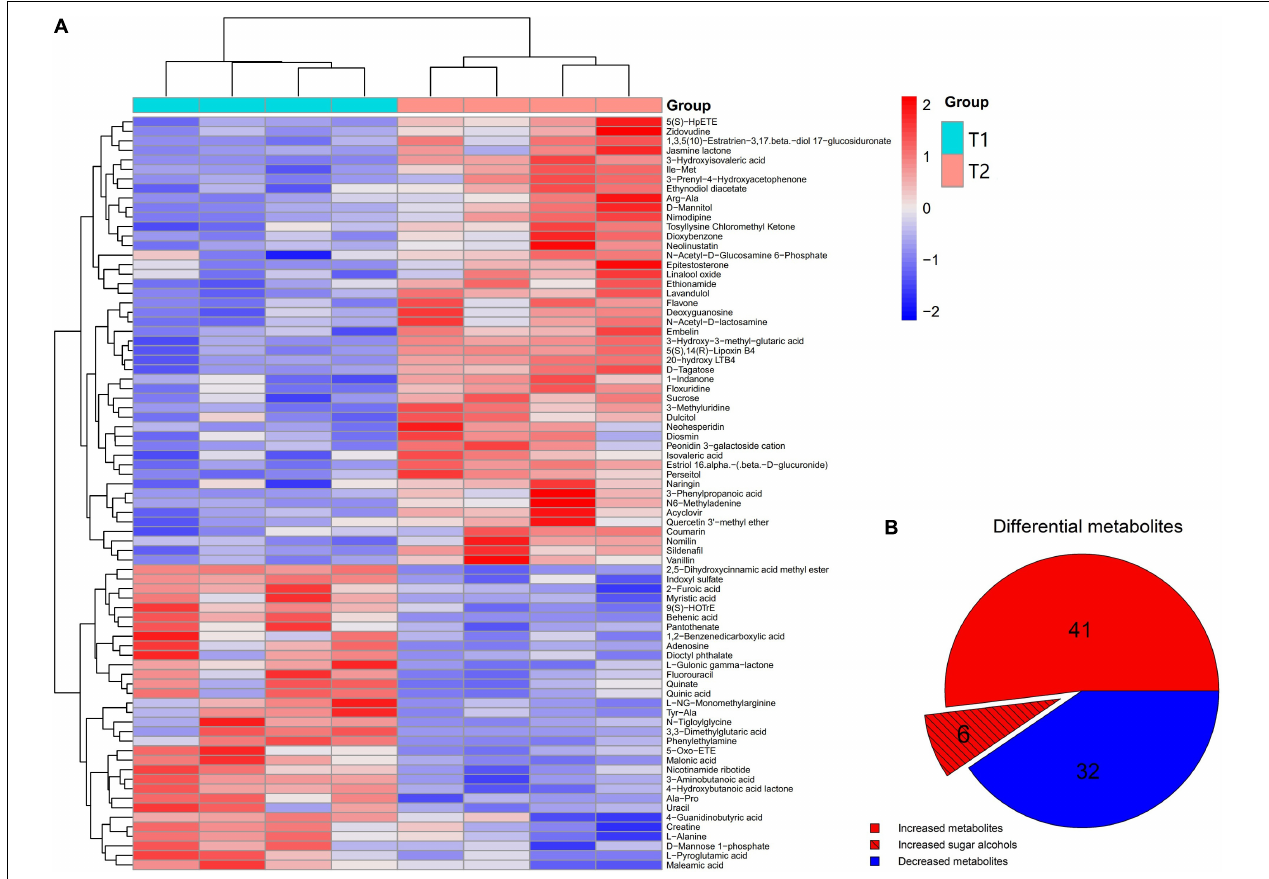
FIGURE 4 | Unsupervised hierarchical clustering heat map of metabolites from the phloem sap of navel orange (A) and pie graph of the statistical analysis of differential metabolites (B) . Metabolites were compared as obtained between the phloem saps of foliar-water (T1) plants and foliar- 10 B (T2) plants.